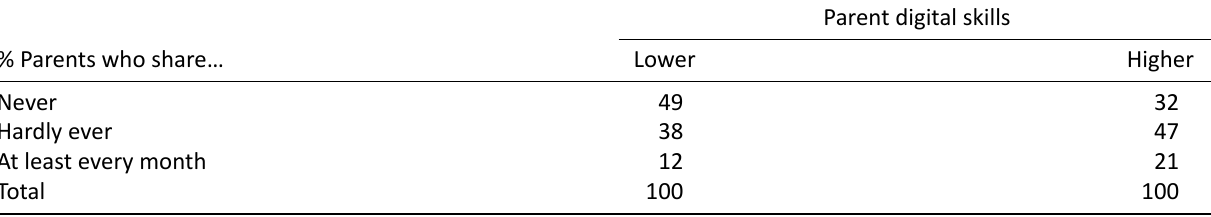
Table 1. How often do you share/post/blog photos/videos of your child online? By parent digital skills.